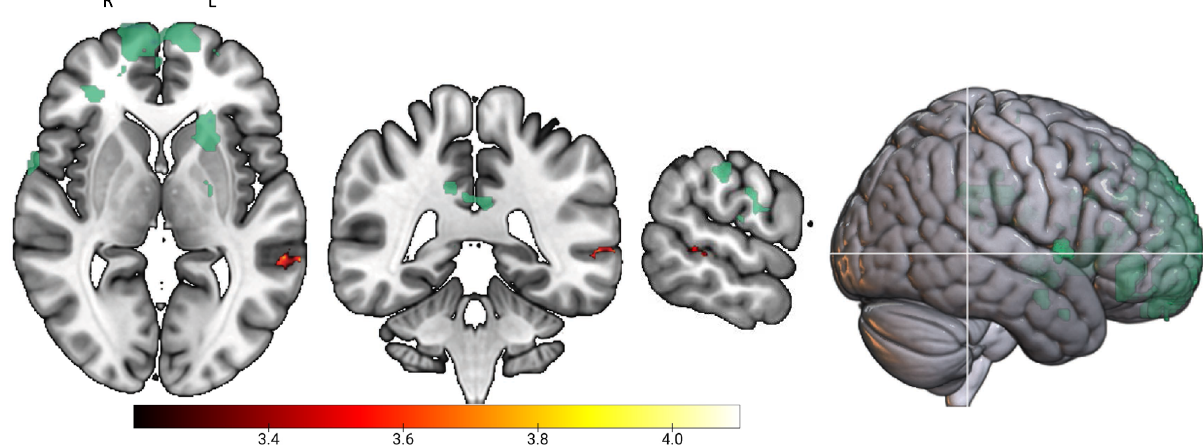
Figure 5. An increased activation in the left middle temporal gyrus extending to the superior temporal sulcus during encoding of faces was apparent for TBI compared to healthy controls. There was no overlap between this cluster (red/yellow) and TBI lesions